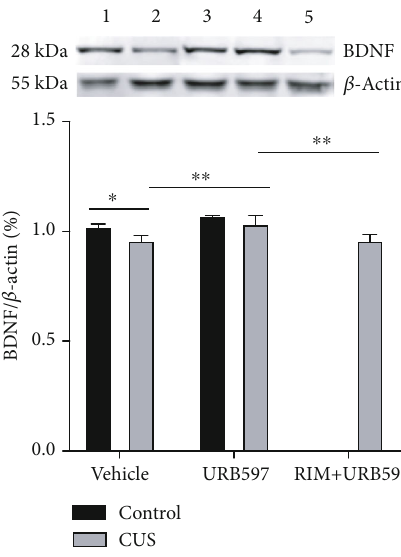
Figure 6: BDNF expression in the hippocampus. 1, control; 2, CUS; 3, CUS+URB597; 4, URB597; 5, CUS+RIM+URB597. Columns represent average of relative intensity of BDNF to β − actin ± SEM , n = 6 /group; ∗ p ≤ 0 : 05 ; ∗∗ p ≤ 0 : 01 . Two-way ANOVA post hoc Holm-Sidak ’